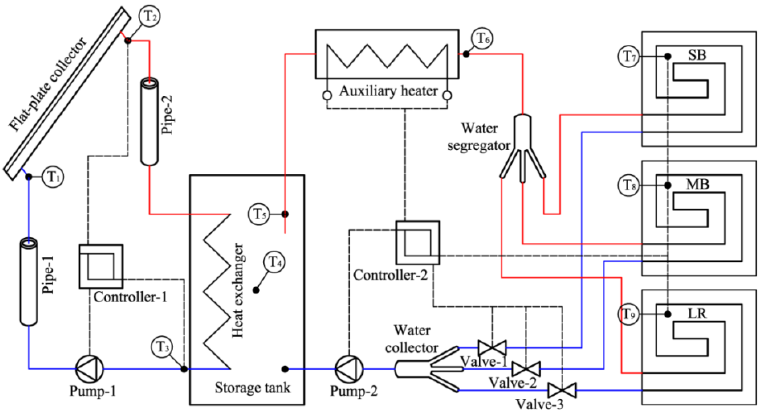
Figure 2. Plane layout and size of the demonstration building.